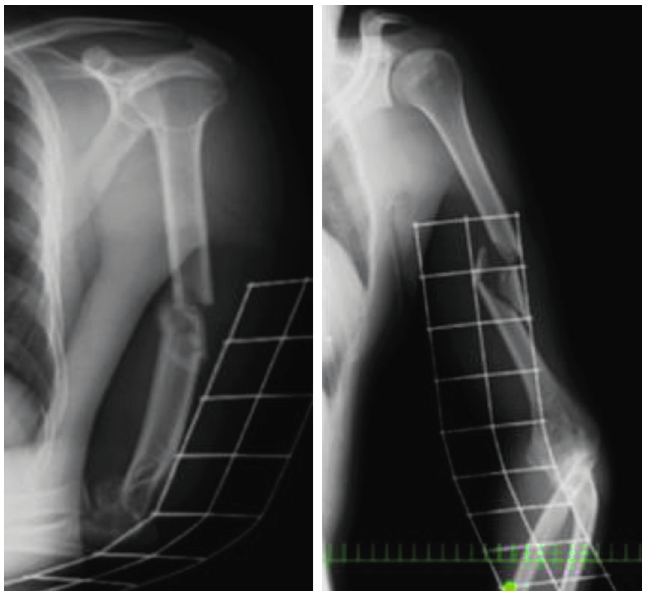
Figure 1: Radiographs of a left humeral shaft fracture. A fracture can be seen with the third and fourth fragments in the mid shaft. The AO- OTA classi fi cation of this fracture is 12-C3.